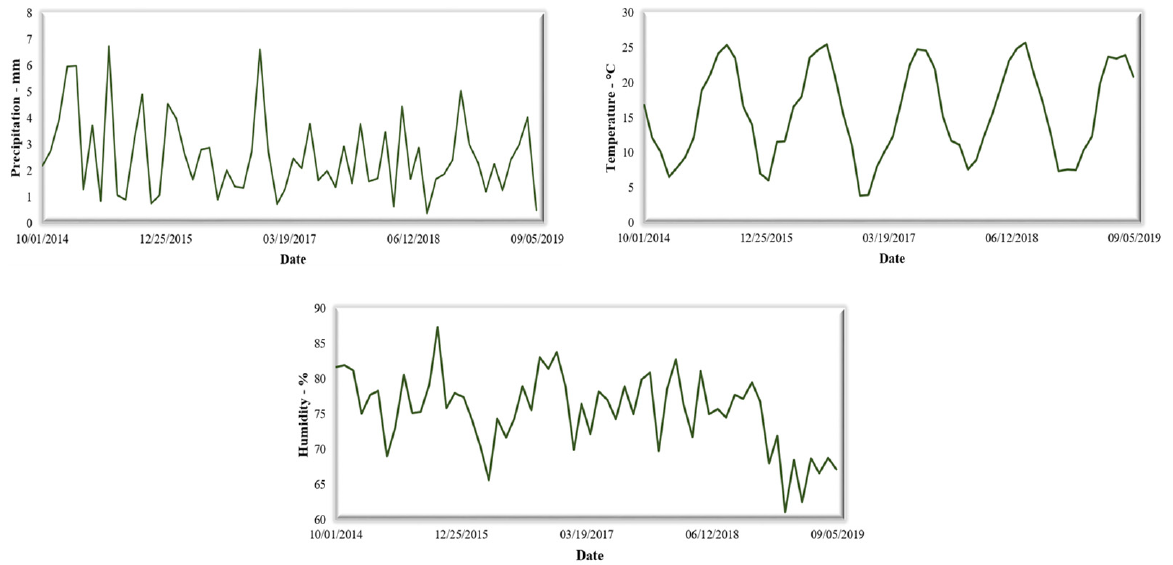
Figure 3. Physical Parameters of precipitation, Temperature and Humidity of Sakarya Province.